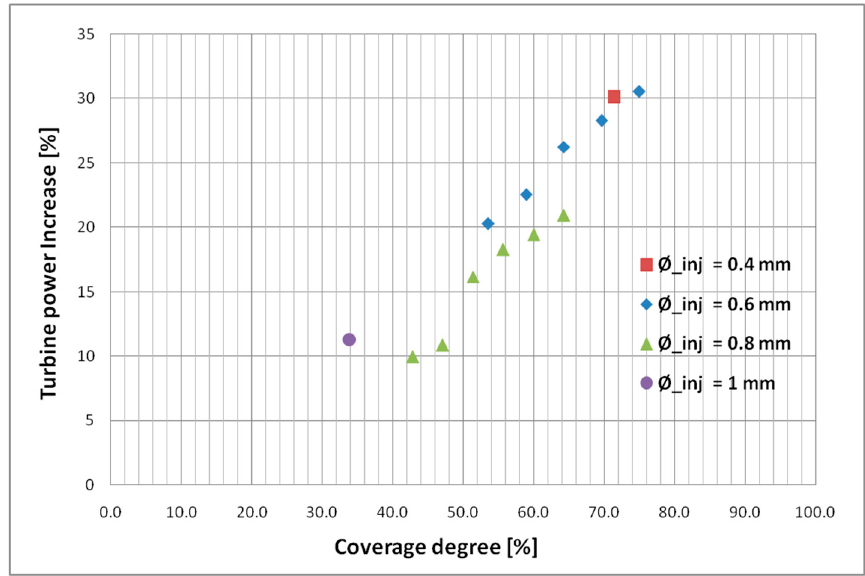
Aerospace 2023 , 10 , x Figure 9. Turbine power increase for coverage degree variation. Figure 9. Turbine power increase for coverage degree variation.